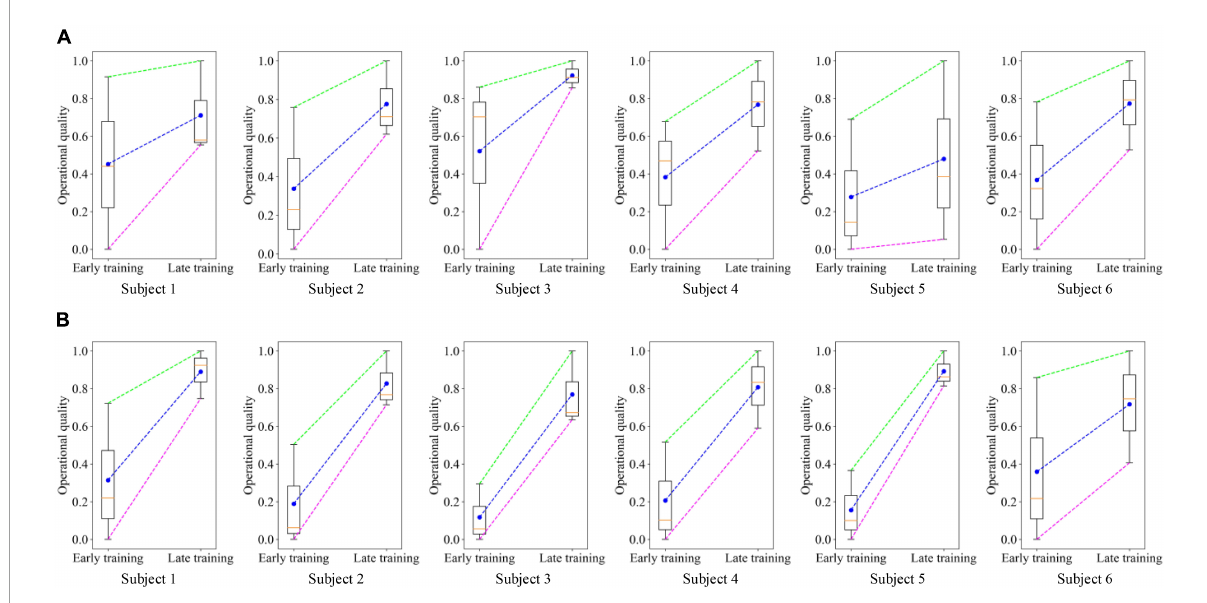
FIGURE13 Boxplots were drawn based on the operational quality of all subjects in the early (the first 3 rounds) and late (the last 3 rounds) stages of PSA model training. The dots in the figure represent the mean value, and the horizontal line represents the median. (A) Trajectory tracking task. (B) Target positioning task.